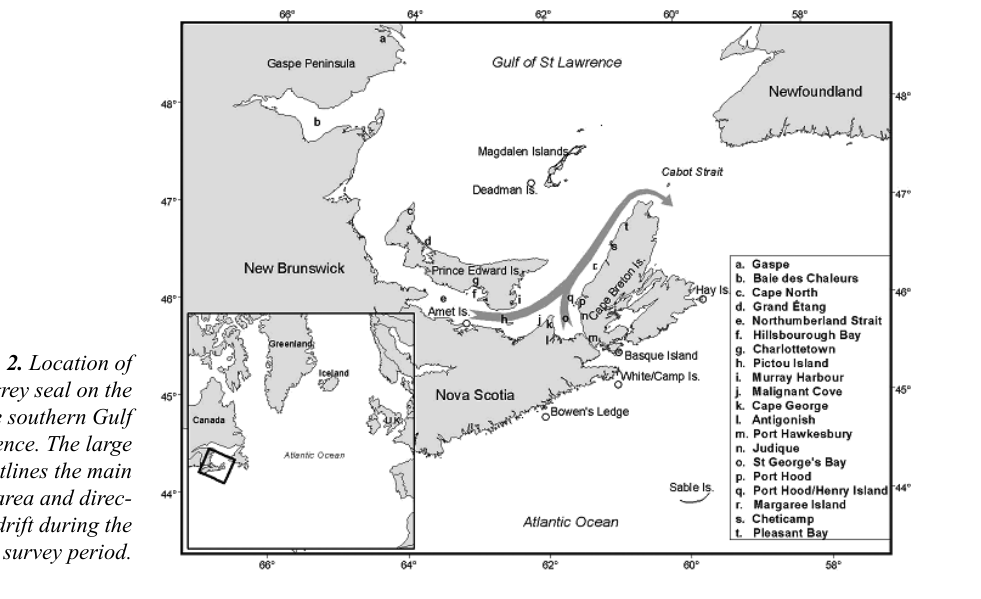
Fig. 2. Location of whelping grey seal on the ice in the southern Gulf of St Lawrence. The large arrow outlines the main pupping area and direc - tion of ice drift during the survey